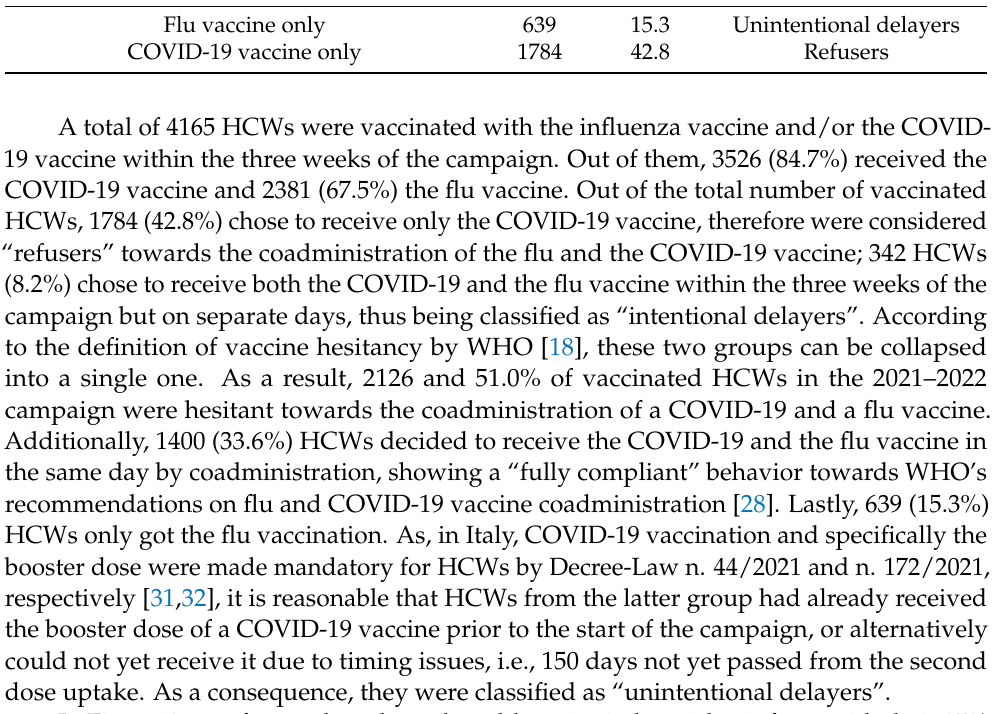
Table 4. HCWs’ influenza vaccine and/or COVID-19 vaccine uptake; attitude towards vaccine coadministration. Vaccine Uptake n % Attitude Total vaccine uptake Total COVID-19 vaccine uptake 2381 67.5 Influenza AND COVID-19 vaccine uptake COVID-19 + Flu vaccine by co-admin. 1400 33.6 COVID-19 + Flu vaccine separated 342 Influenza OR COVID-19 vaccine